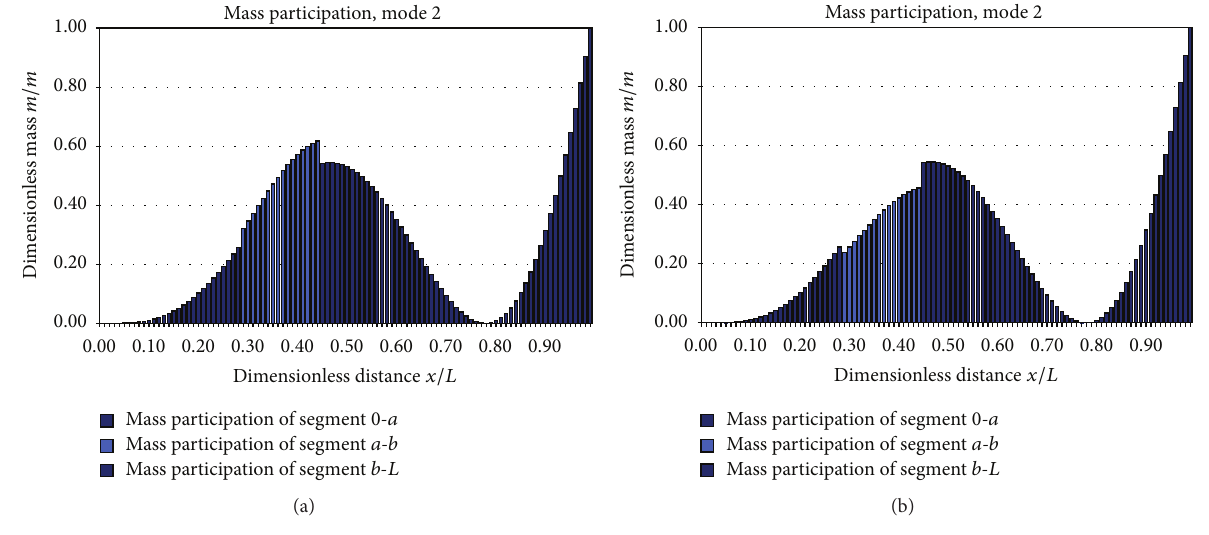
Figure 6: The mass participation in the total kinetic energy for 100 slices placed along the beam: (a) in case of supplementary mass; (b) in case of mass loss. Table 1: Parameters reflecting the segments affected by mass alteration, large